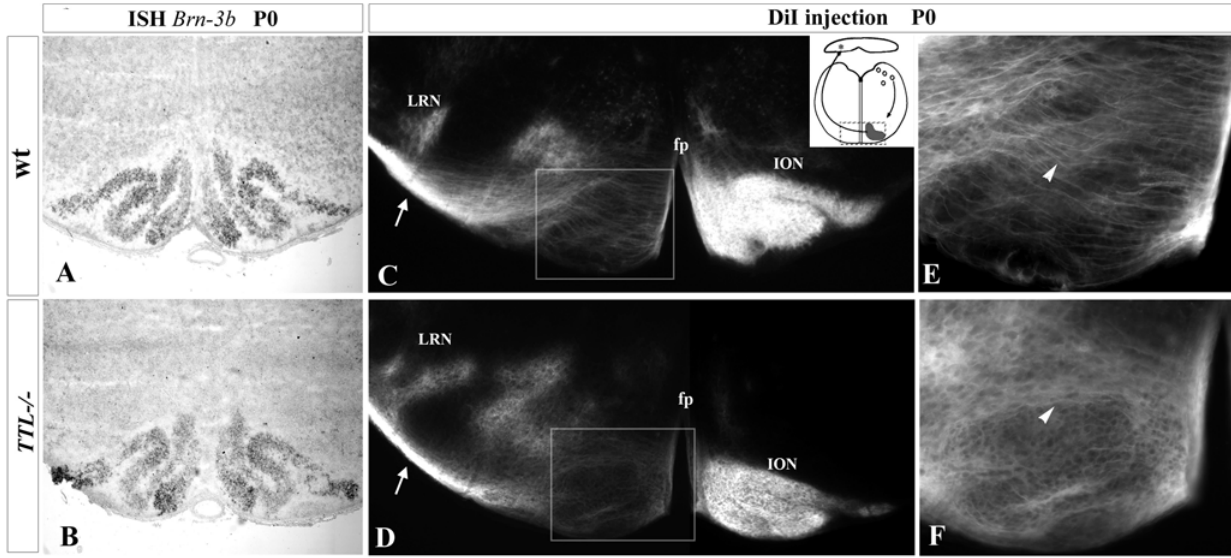
Figure 1. Correct positioning of ION cell bodies but impaired aspect of ION fibers in TTL 2 / 2 newborn mice. (A, B) At birth, a Brn-3b probe allowed the visualization of the whole ION (Inferior Olivary Nucleus) lamellae in wt (A) and TTL 2 / 2 mice (B) upon ISH. ION rostral lamellae were properly developed in TTL 2 / 2 mice. (C–F) Upon unilateral DiI injections in the cerebellum (left side and schema in C) and retrograde PCN labeling at birth, in wt mice (C), the ION located controlateral to the injection site and the ipsilateral lateral reticular nucleus (LRN) were labeled. Crossing fibers of the olivary commissure were visualized ventrally in the olivary region (white arrowhead in E). In TTL 2 / 2 mice, ION neurons were also labeled controlaterally to the injection site (D), but showed a disorganization of ION fibers in the ION mass, once they have crossed the floor plate (fp) and locate ipsilaterally to the injected cerebellum that they reach (white arrowhead in F). LRN was correctly labeled ipsilaterally (D). For each genotype, 4 newborn mice were analyzed after DiI